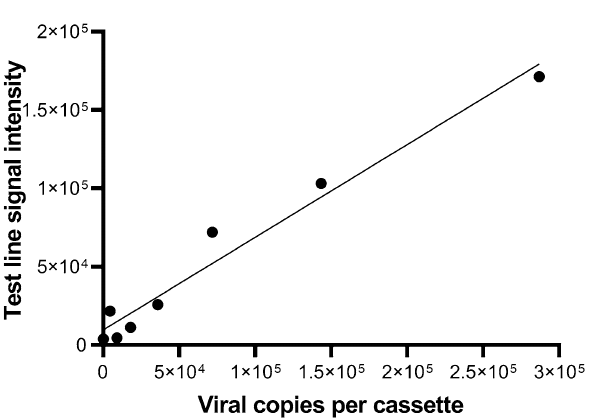
Figure 4. Detection of SARS-CoV-2 antigen is proportional to viral input. RDS-2500 reader quantified test line intensity of serially diluted SARS-CoV-2 heat-inactivated virus spiked into negative nasal swab sample matrix. Test line signal counts were correlated to viral copy input with a resultant R 2 of 0.9684.